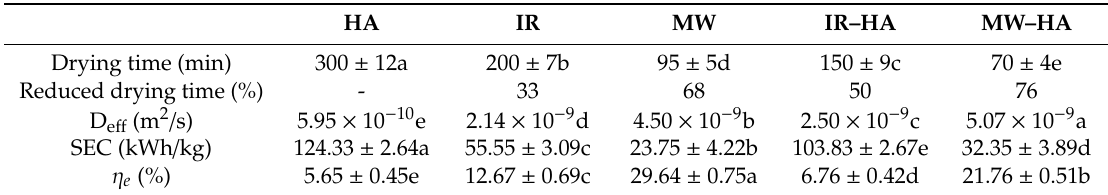
Table 5. Analysis of variance (ANOVA) for the effect of drying methods on antioxidant capacity (AntiOX), total phenol content (TPC), total flavonoid content (TFC), and pH of terebinth.